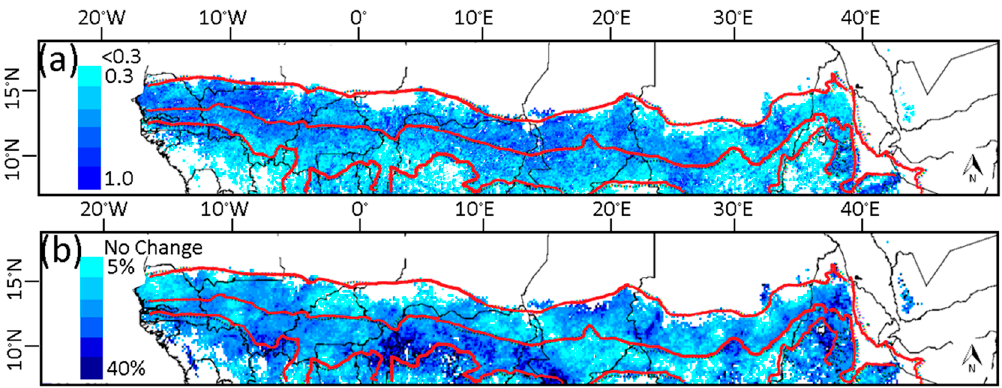
Figure 8. Adjusted r 2 for ( a ), the relation of Σ NDVI with total growing season rainfall, air humidity and temperature. ( b ) The change in the percentage of variance explained by including the additional variables over the percentage variance of Σ NDVI and rainfall alone. The red lines from north to south are the 300 mm, 700 mm and 1100 mm rainfall isohyets.